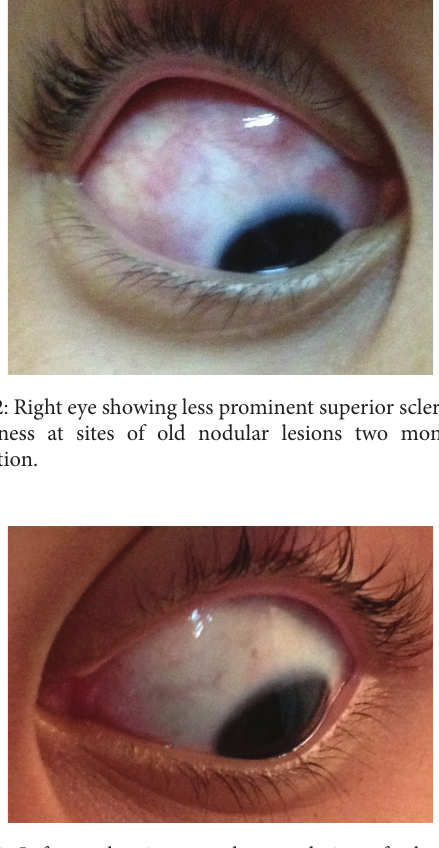
Figure 3: Left eye showing complete resolution of scleral lesions four months after